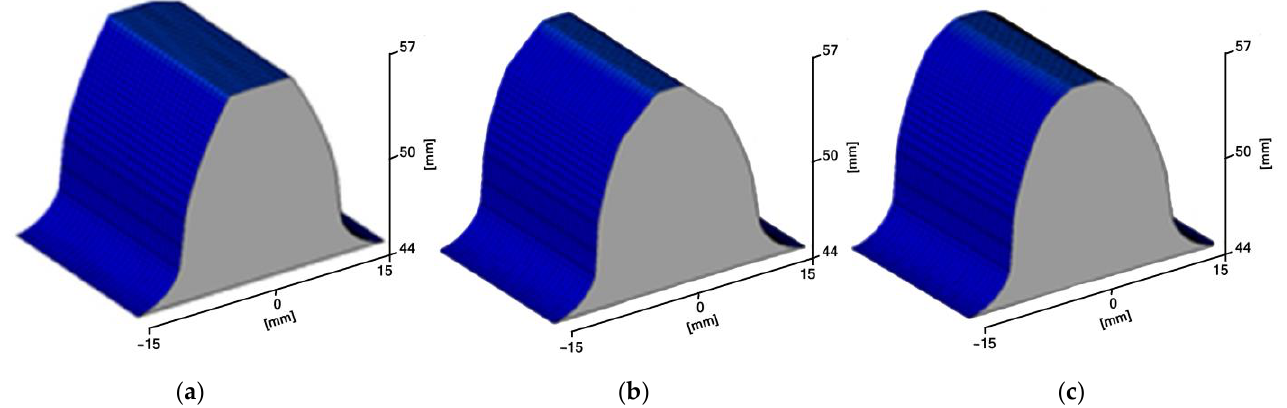
Figure 3. Tooth profiles. ( a ) involute without modification, ( b ) involute with modification along an arc of the head of the tooth, ( c ) involute with modification along a straight line of the head of the tooth.